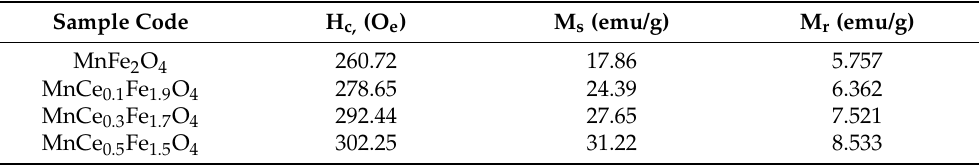
Table 2. Remnant (M r ), Coercivity (H c ), and saturation (M s ) values of spinel MnCe x Fe 2 − x O 4 (x = 0.0, 0.1, 0.3 and 0.5) NCs.